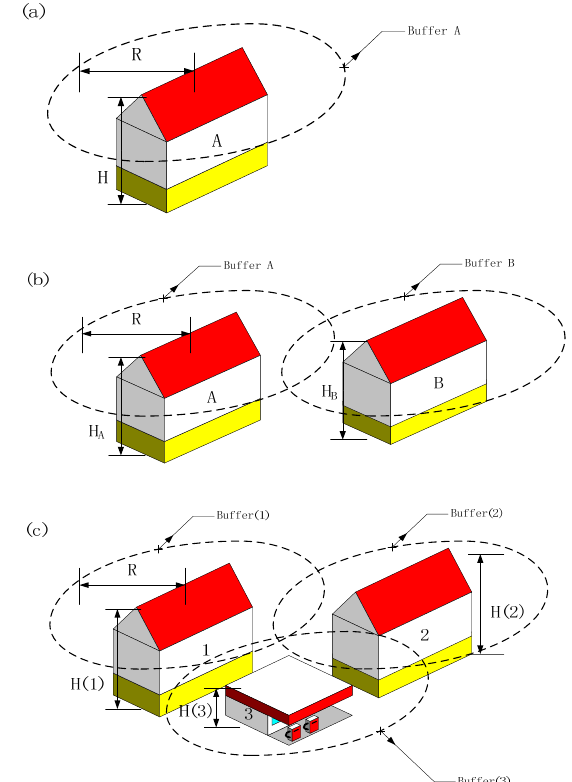
Figure 3. Schematic representations of (a) building A with its cov- ering distance of collecting radius, and its collection area, buffer A; (b) two neighbouring buildings (A and B) and intersecting collec- Fig. 3. Schematic representations of (a) building A with its covering distance of collecting 631 tion areas; and (c) more than two neighbouring buildings and their intersecting collection radius, and its collection area, buffer A; (b) two neighboring buildings (A and B) and 632 intersecting collection areas; and (c) more than two neighboring buildings and their 633 intersecting collection areas. 634